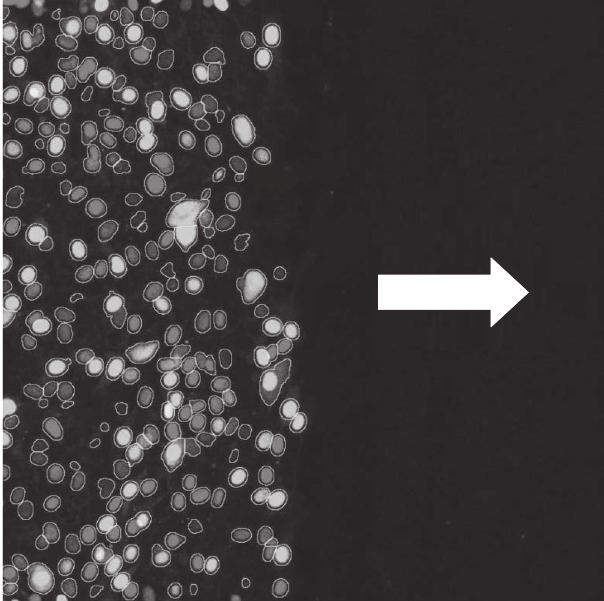
Fig. 2 Typical initial frame of the experimental data. The cells are positioned such that they will migrate primarily horizontally into the space without cells, this space represents a wound (the direction of migration is indicated by the white arrow